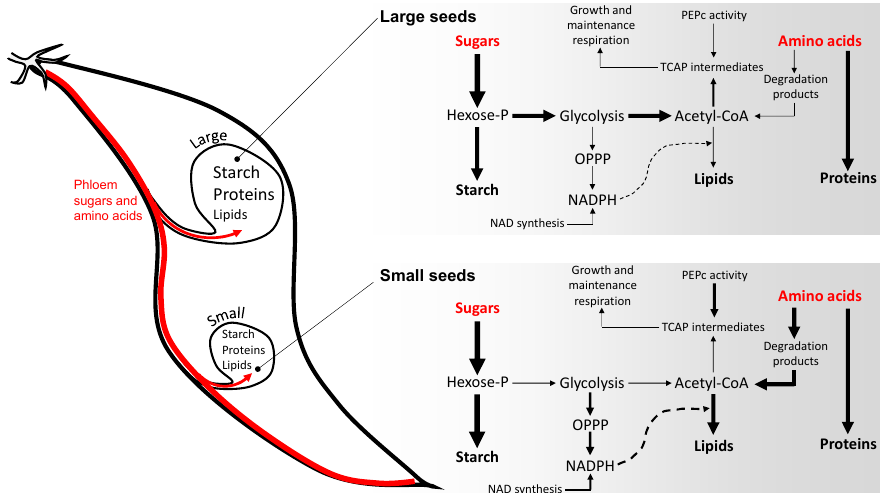
Figure 5. Metabolic changes during maturation associated with seed size. This figure is a simplification based on major products imported from the phloem: sugars and amino acids. Probable relative fluxes are represented with arrow thickness. In small seeds, the lower input from phloem sugars and amino acids (either from sink or source effects) leads to the preferential utilisation of sugars to maintain starch content, and thus an increased utilisation of amino acids as a carbon source, including to synthesise lipids. Increased lipid synthesis goes along a concurrent increase in NADPH production and thus redox power provision. The change in acetyl-CoA partitioning is also associated with an increase in anaplerotic activity, leading to an increased malate content. See main text ( Discussion ) for further details.